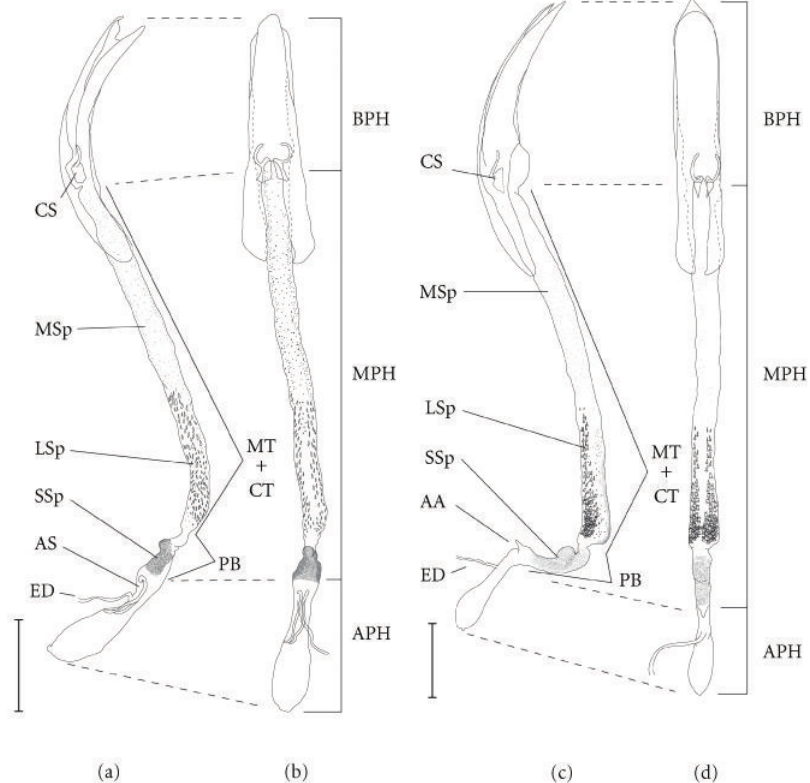
Figure 2: Comparison of the type species of Mesosa ( Mesosa ) and Agelasta ( Dissosira ). (a, b) M. ( M. ) curculionoides ; (c, d) A. ( D. ) catenata ; (a, c). median lobe with endophallus in lateral view; (b, d) ditto in dorsal view. Scale: 1.0mm. For abbreviations see